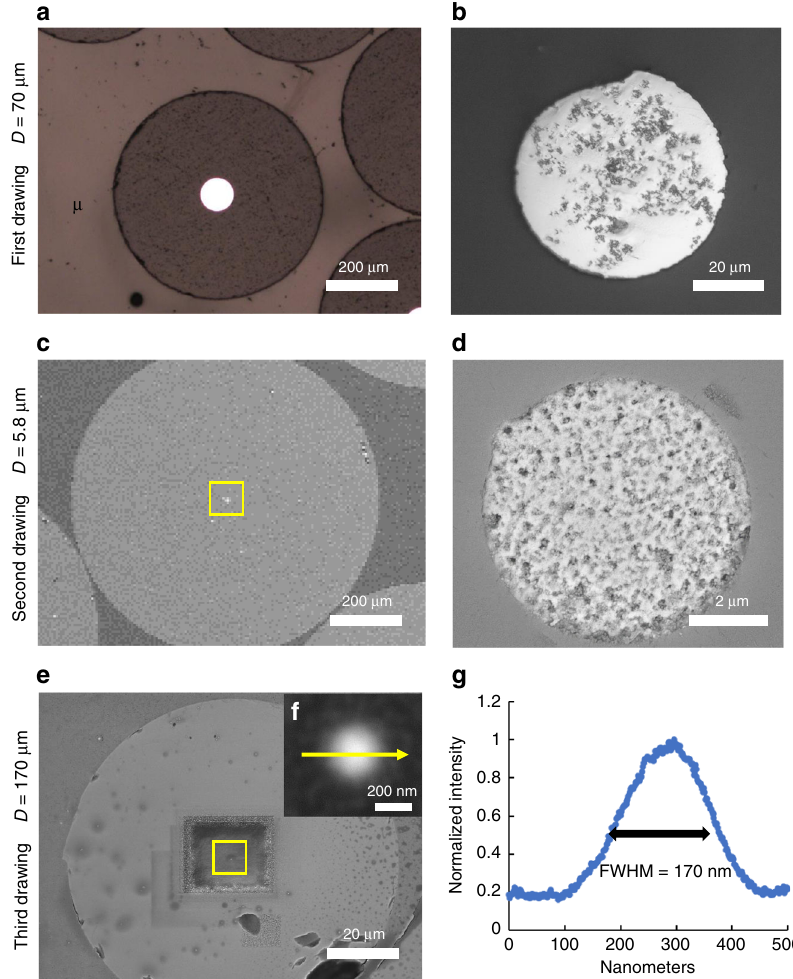
Fig. 2 Characterization of Zn-WC nanowires embedded in glass cladding. a , b Cross-sectional optical/SEM images of Zn-WC nanocomposite nanowires after the fi rst drawing (70 µ m). c , d Cross-sectional SEM images after the second drawing (5.8 µ m). e , f Cross-sectional SEM images after the third drawing (170 nm). g EDS line scanning of Zn-WC nanowire on the cross-section, indicated by the yellow arrow in f . The diameter of the nanowire was measured to be 170